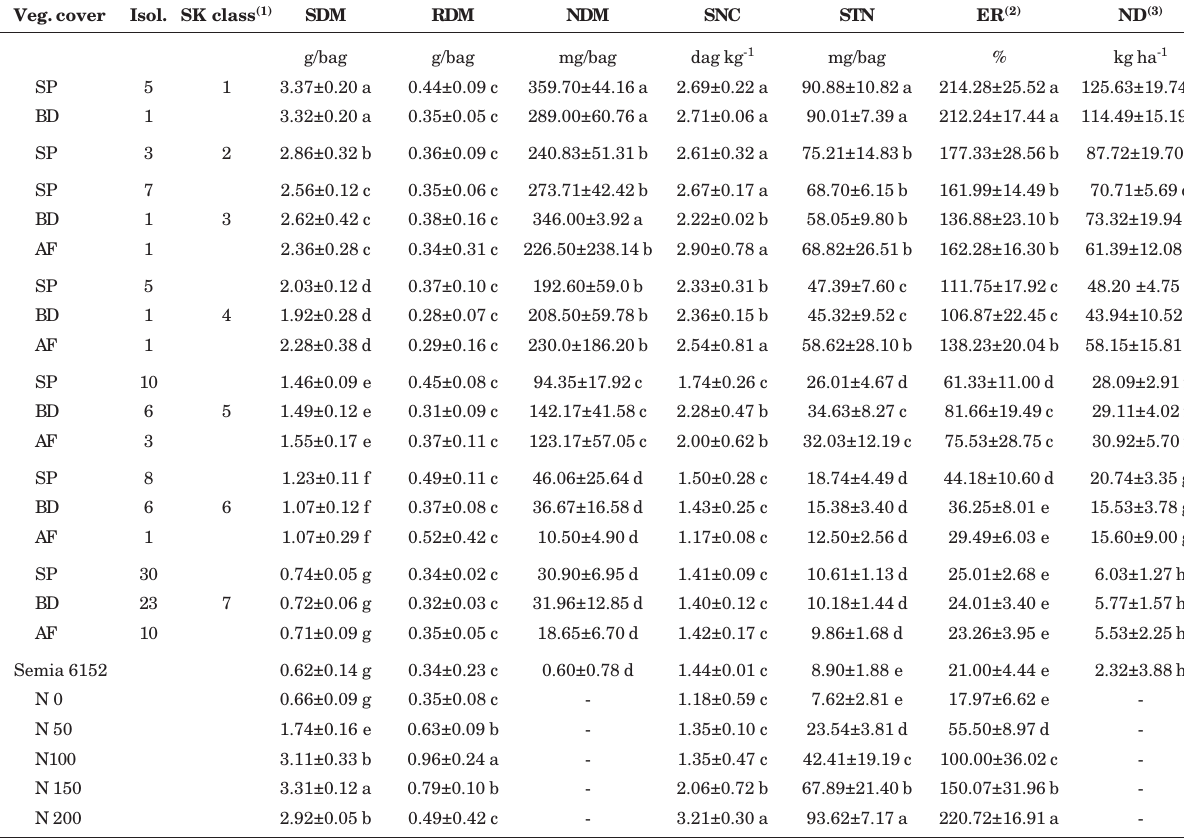
Table 2. Average shoot (SDM), root (RDM) and nodule (NDM) dry matter, shoot N content (SNC) and total N (STN), relative efficiency (RE) and N dose (ND) associated with a given SDM yield under inoculation with rhizobial isolates from B. decumbens pastures (BD), sabiá plantations (SP) and Atlantic Forest (AF) areas in the Dry Forest Zone of